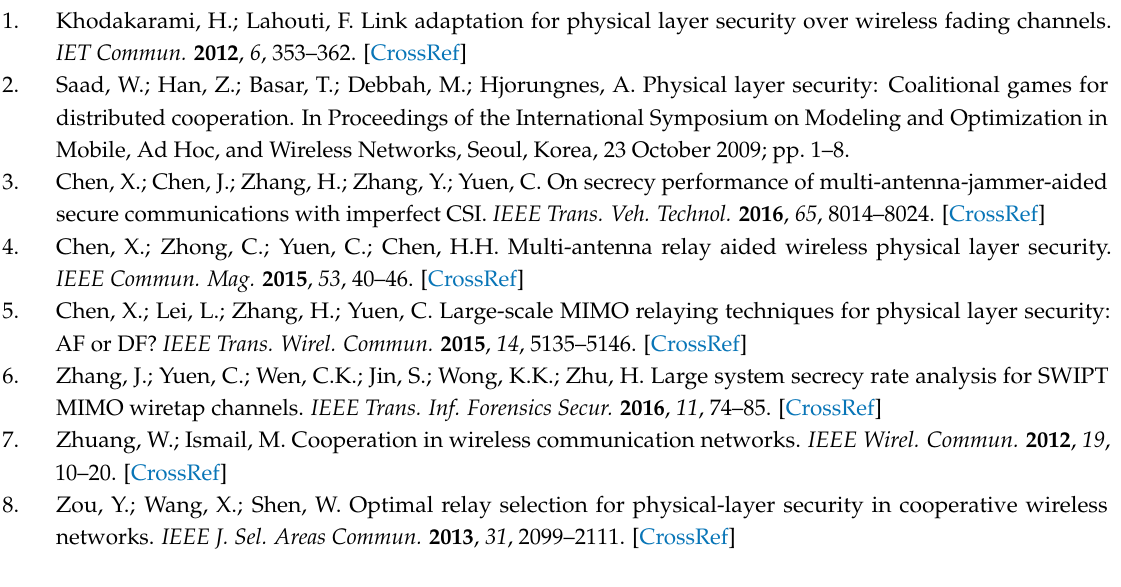
Figure 7. Channel capacity and eavesdropper capacity with different number of sources versus P S